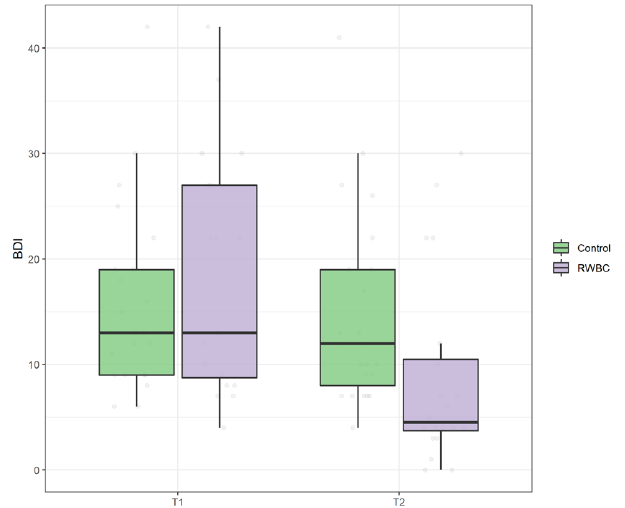
Figure 5. Boxplot of Beck Depression Inventory (BDI) scores at T0 and T1 in control group and in- tervention group